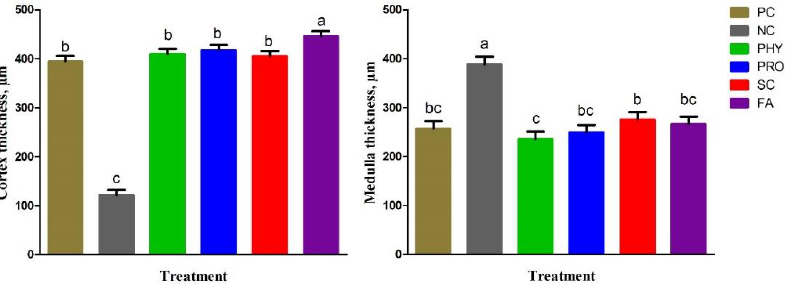
Figure 2. Effect of dietary treatments on cortical bone thickness and medullary area of tibia in broiler chickens at 35 d of age. Data represented as mean ± SEM. a–c Means with different letters varied at p ˂ 0.05. For treatment abbreviations, see Table 2.